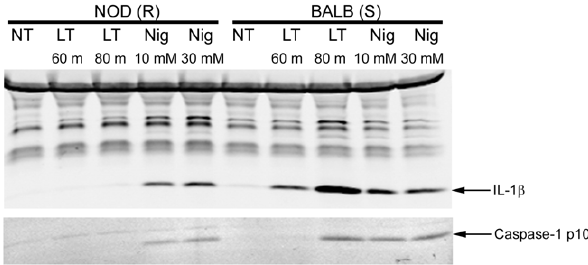
Figure 4. Caspase-1 activation in bone marrow-derived mouse macrophages. LPS-primed (1 m g/ml, 2 h) bone marrow-derived macrophages from Balb/cJ or NOD/LtJ mice were treated with LT (1 m g/ml) for 60 or 80 min, or with nigericin at indicated doses for 20 min. Cell lysates were analyzed by Western blotting for IL-1 b , and the same samples were probed with caspase-1 p10 antibody to detect caspase-1